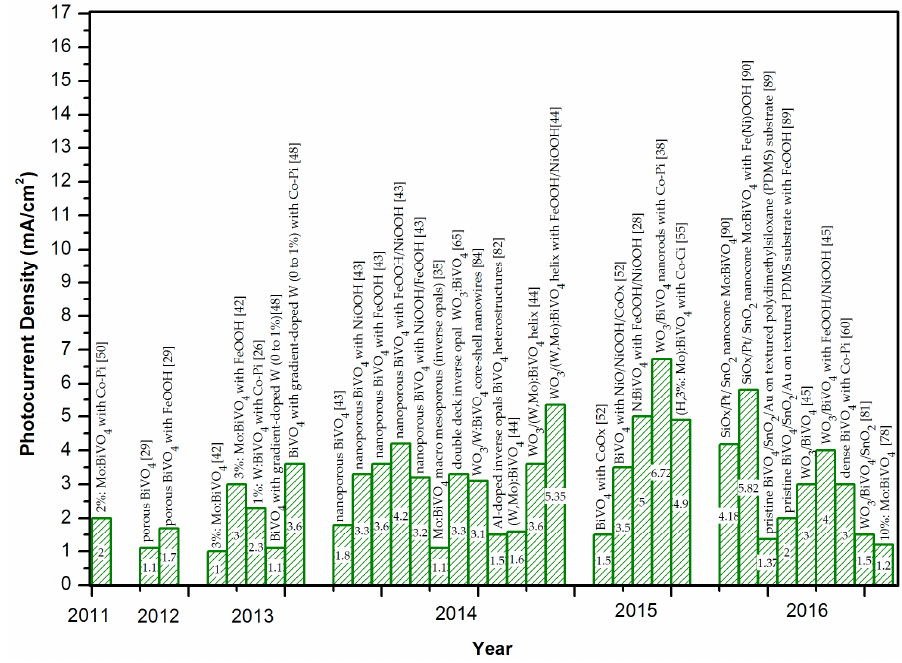
Figure 1. Top ‐ performing BiVO 4 ‐ based photoanodes from 2011 to 2016 (measured at a standard illumination of AM 1.5 G, and an intensity of 1 sun (100 mW/cm 2 ), obtained at 1.2–1.23 V vs. RHE).